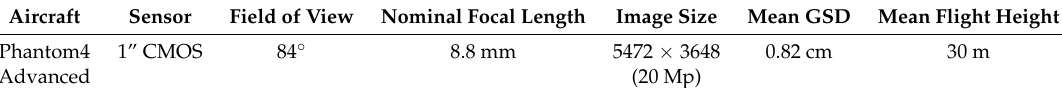
Table 1. Aircraft and flight specifications.